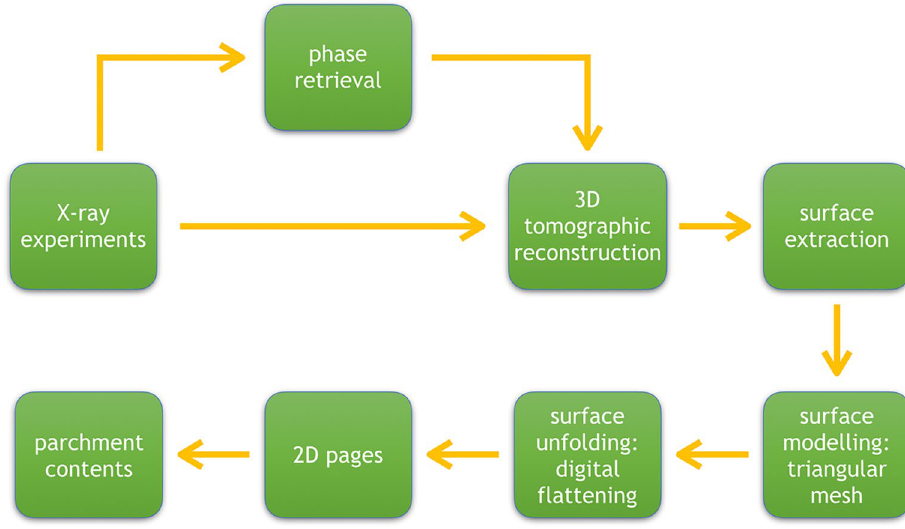
Figure 2. Pipeline for investigation of papyri.